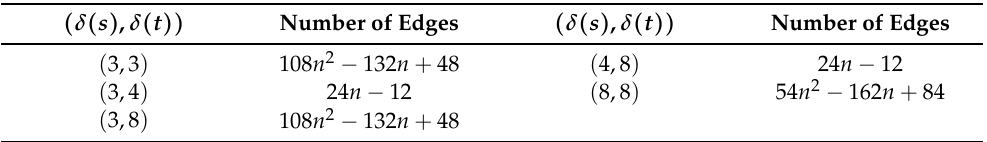
Table 3. Degree-Based Edge Partition for BDPOH ( n )